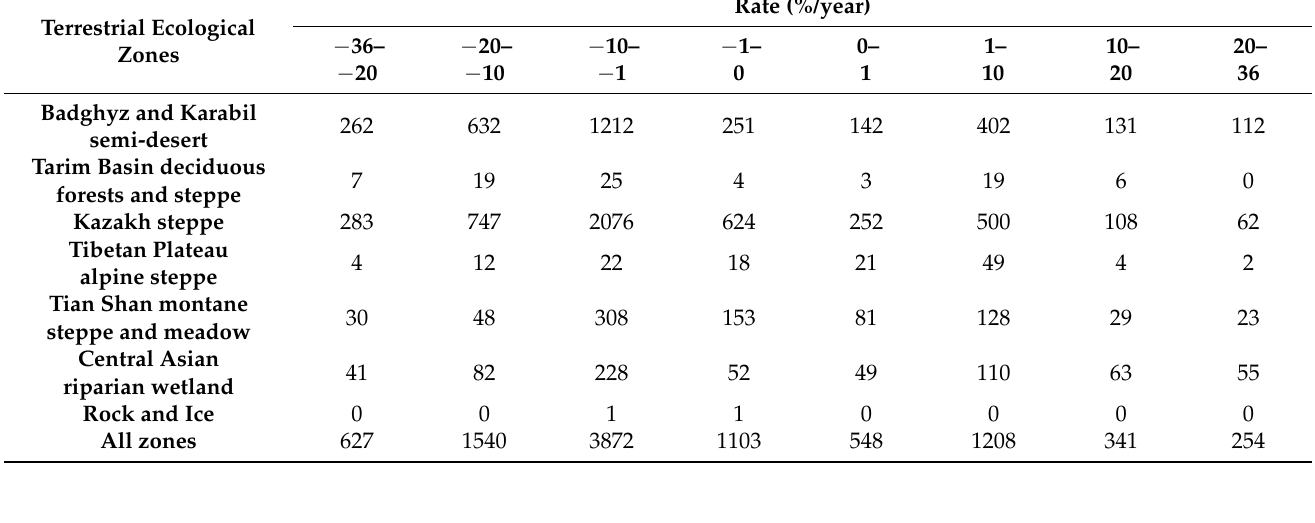
Table 5. The number of lakes by yearly change rate over seven terrestrial ecological zones in Central Asia as Figure 4.